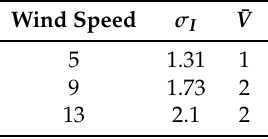
Table 2. Settings of ¯ V (m/s).